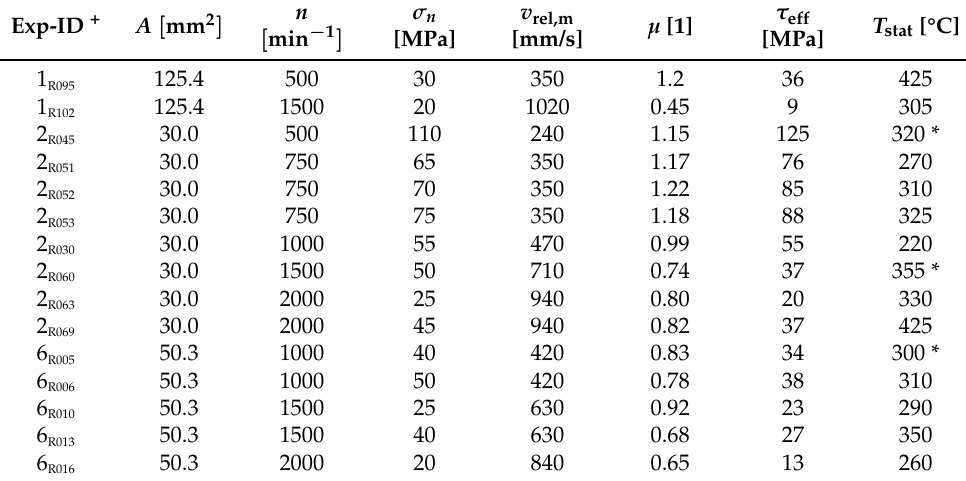
Table 3. Overview of the results for three tool geometries at different pressures and speeds after the friction transition at the end of the respective experiment. Identifier Exp-ID w/ leading tool number, contact area A , spindle speed n , normal pressure σ n , relative velocity v rel,m , friction coefficient µ , effective shear stress τ eff , and quasi-static temperature T stat